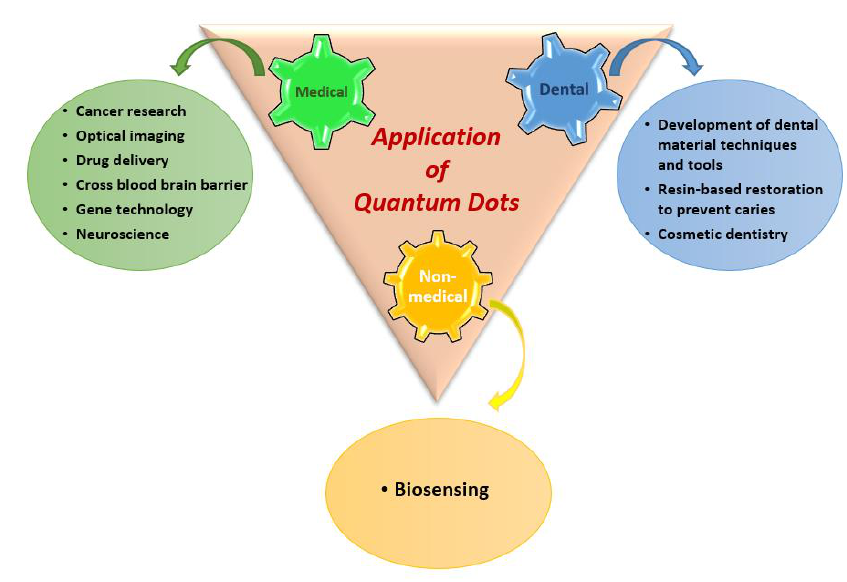
Figure 4. Applications of quantum dots in relation to dentistry.